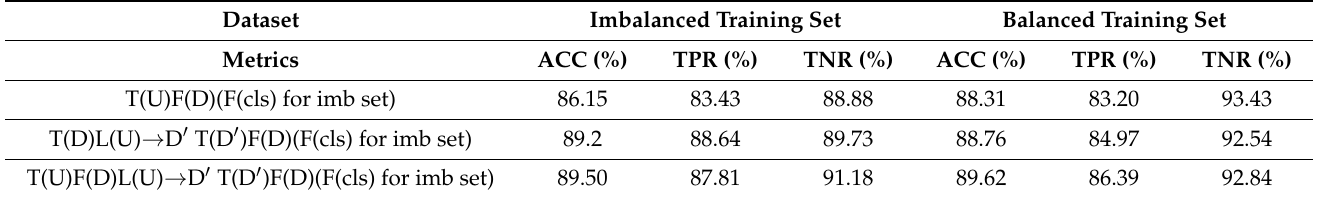
Table 5. Experimental results obtained on DDR test set (imb set, the imbalanced training set).